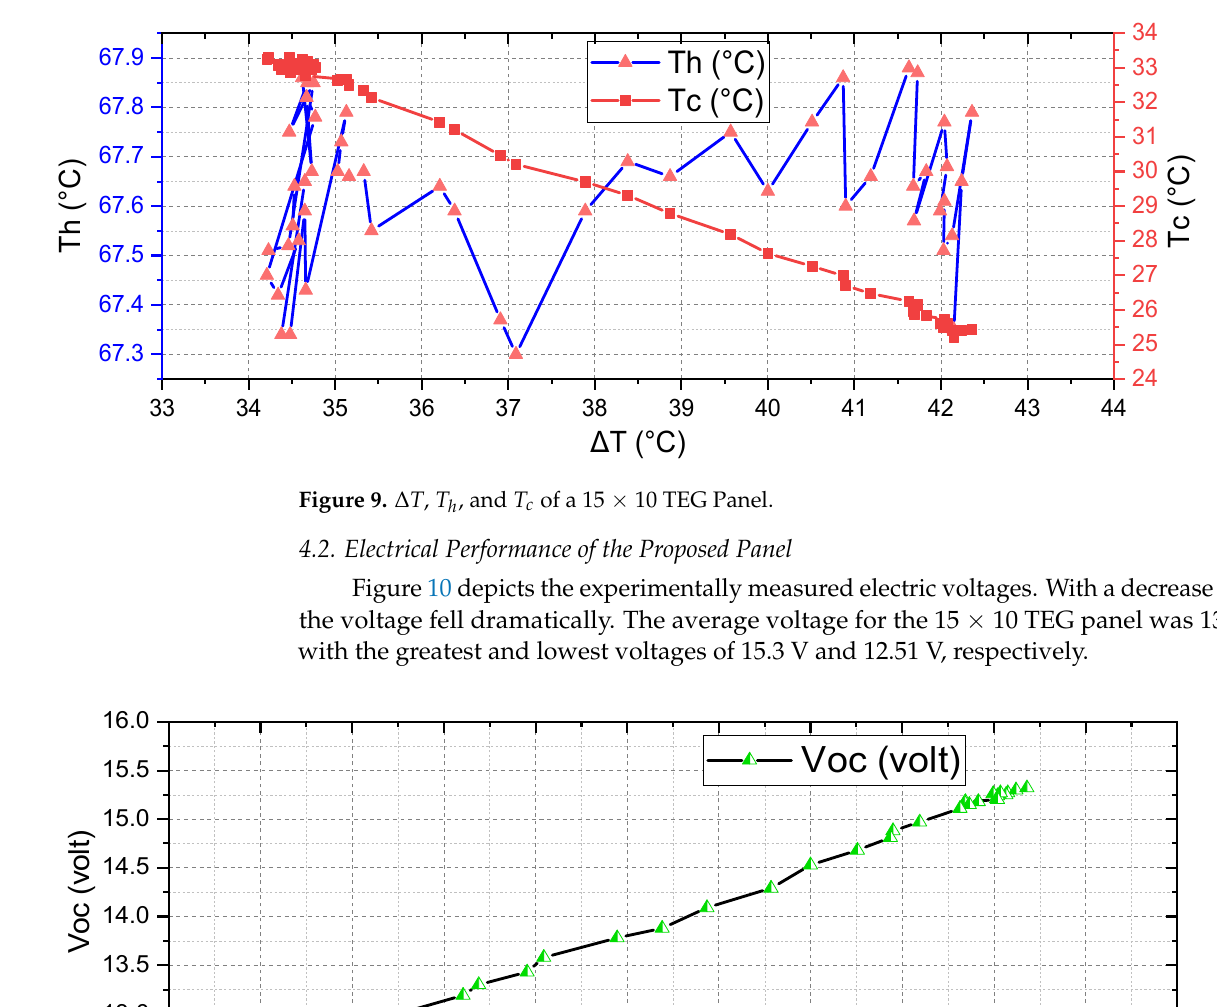
Figure 10. Voltage for 15 × 10 TEG panel systems.